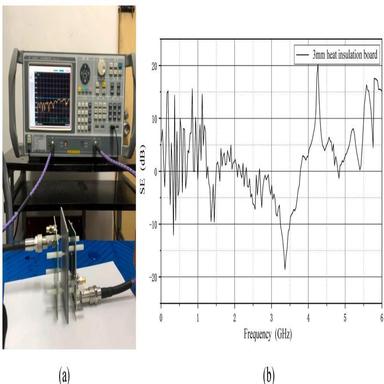
SE test of a 3 mm heat insulation board:(a) practical testing; (b) SE results.